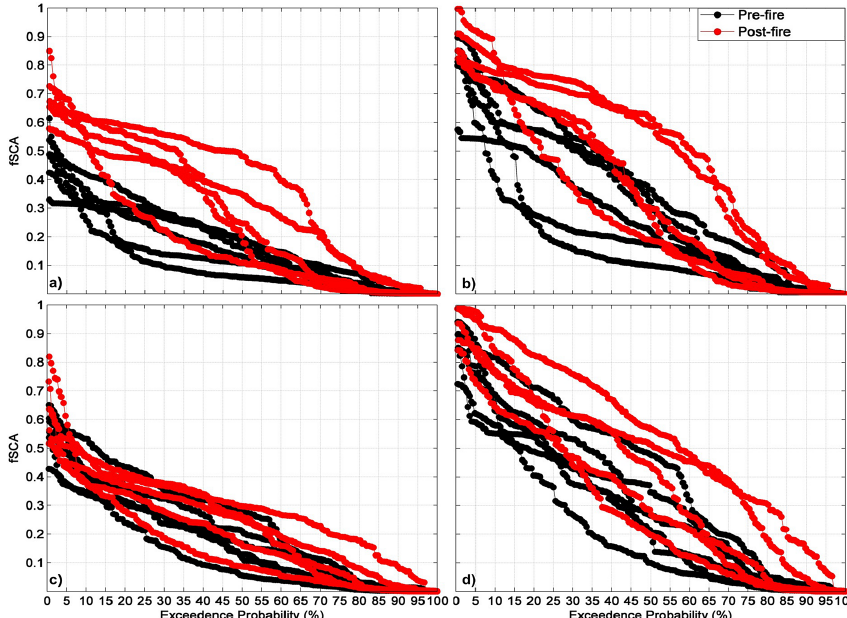
Figure 5. Annual cumulative frequency curves of daily basin-averaged non-canopy-adjusted MODSCAG fSCA for the Moonlight Fire area (a) and Grizzly Ridge (c) and canopy-adjusted MODSCAG fSCA for the Moonlight Fire area (b) and Grizzly Ridge (d) . Black lines with black circles represent extreme pre-fire fSCA years (highest and lowest annual curves) and red circles represent post-fire annual curves.